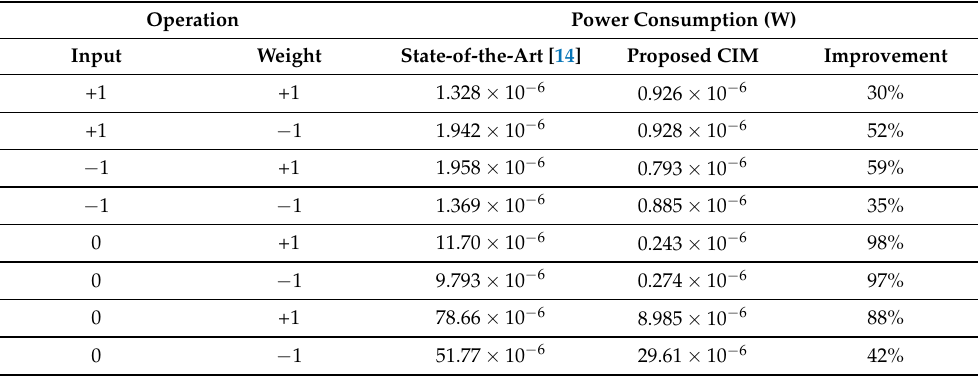
Table 3. Results for Power Consumption.